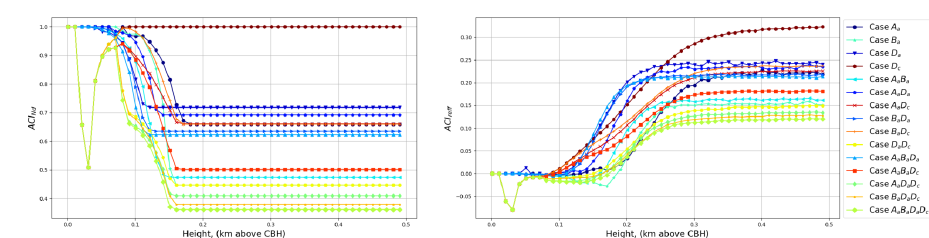
Figure A7. ACI Nd , ACI ref f for different aerosol types according to the legend.